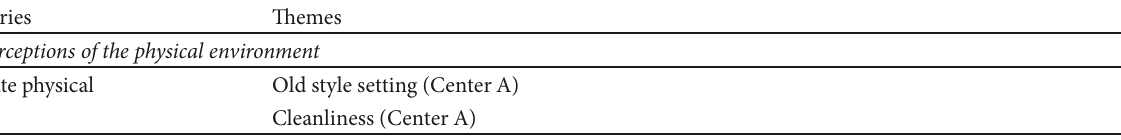
Table 1: Initial themes and subcategories reflecting participants’ views on ADS